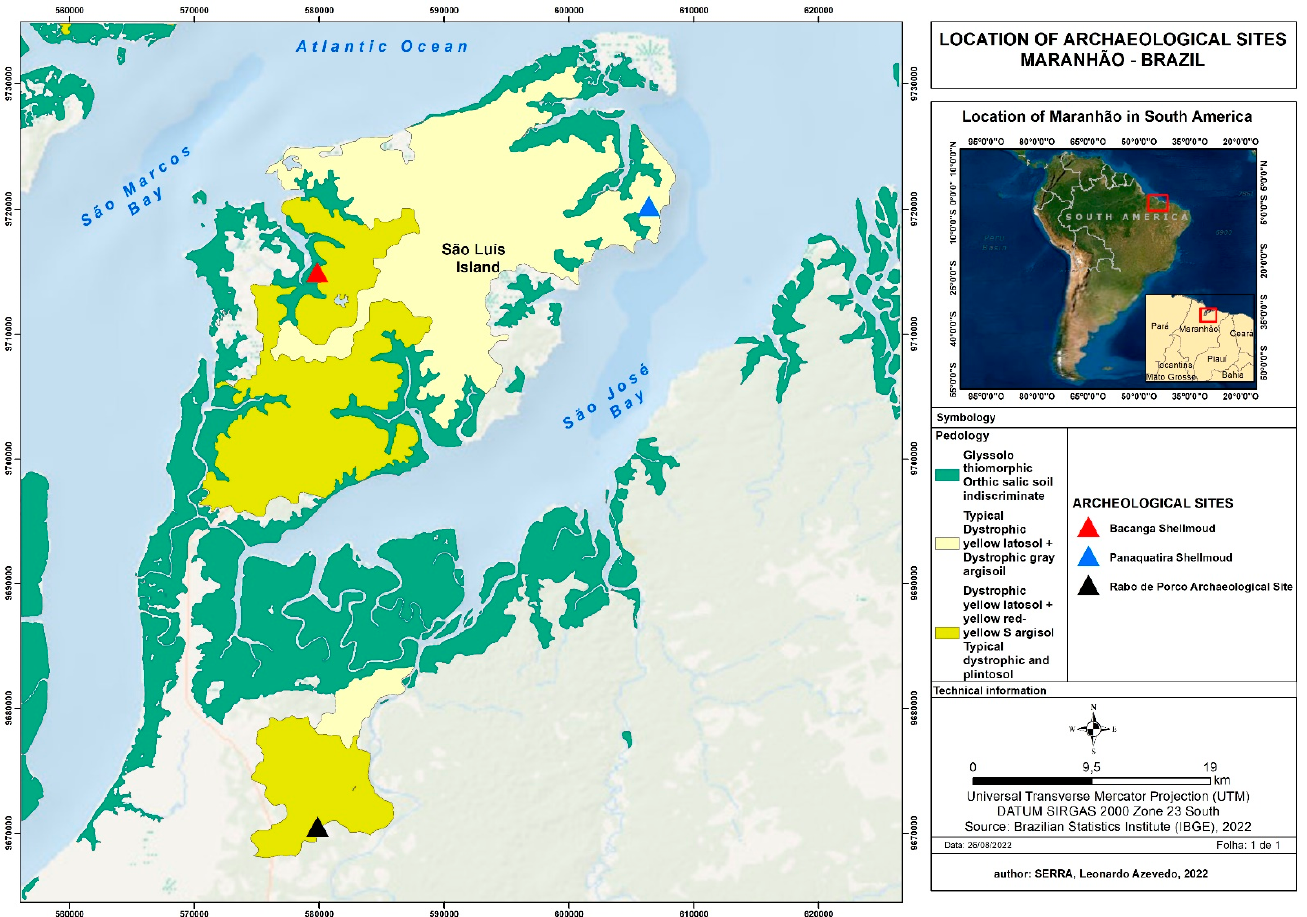
Figure 1. The study areas on the Brazilian Amazon coast with the location of the Panaquatira, Bacanga, and Rabo de Porco sites. Identification of the pedology of the region surrounding the archaeological sites, where the clay raw materials were collected, is shown.